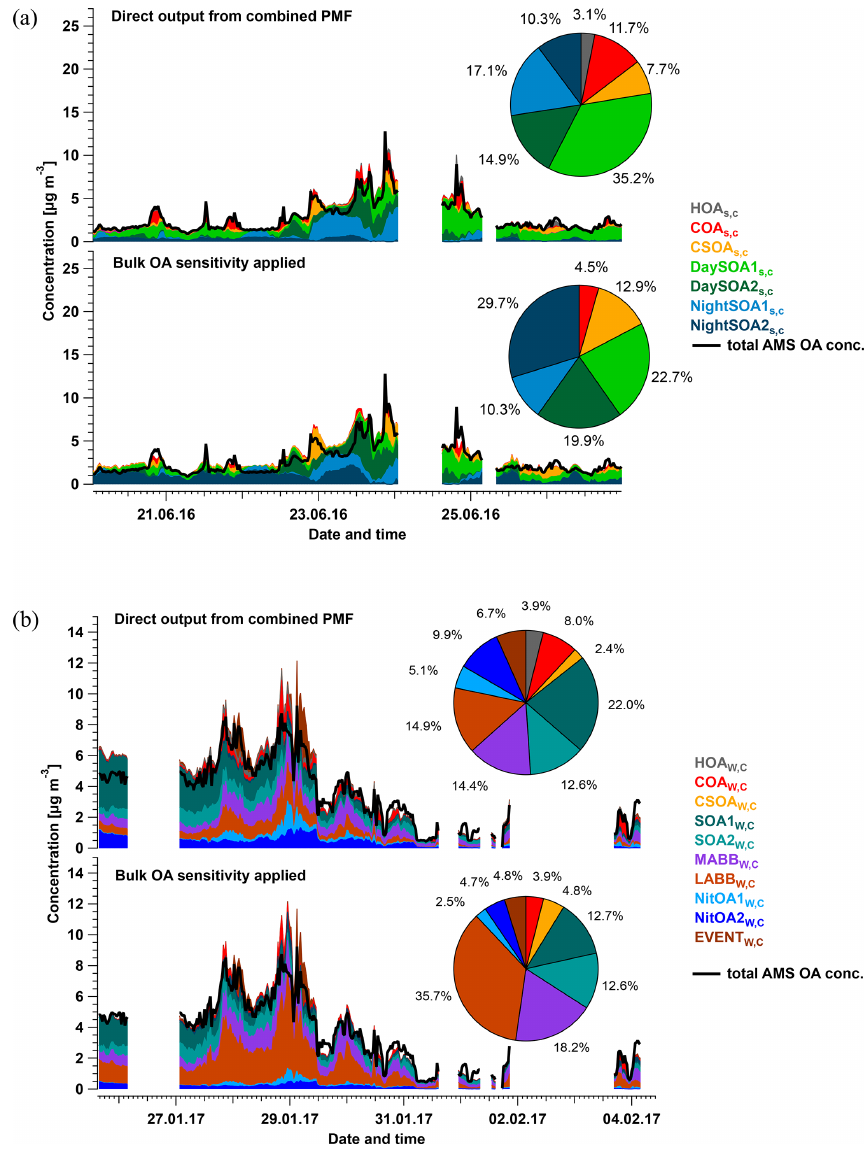
Figure 9. Comparison of source apportionment results between direct output from cPMF (i.e. accounting for factor-dependent sensitivities) and application of a single bulk OA sensitivity, applied to the Zurich summer (a) and winter (b) datasets. Stack plots of factor time series directly from combined PMF and factor time series calculated from bulk OA sensitivity compared with total AMS OA concentration are shown in the upper and lower panel, respectively, in each subfigure, together with the corresponding factor contribution shown in the pie chart. Note that, here, the contribution of the InorgNit factor and the contributions of NO + and NO + are excluded to account only for the total